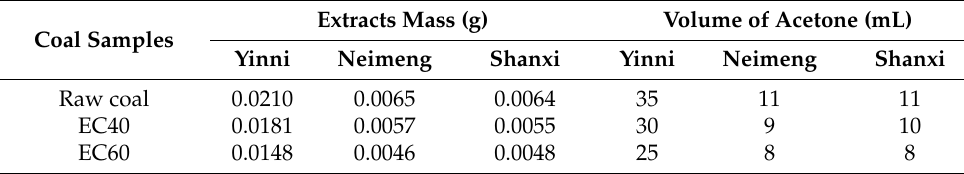
Table 2. The extracts mass and the added volume of acetone for GC/MS analysis. Extracts Mass (g) Volume of Acetone (mL) Coal Samples